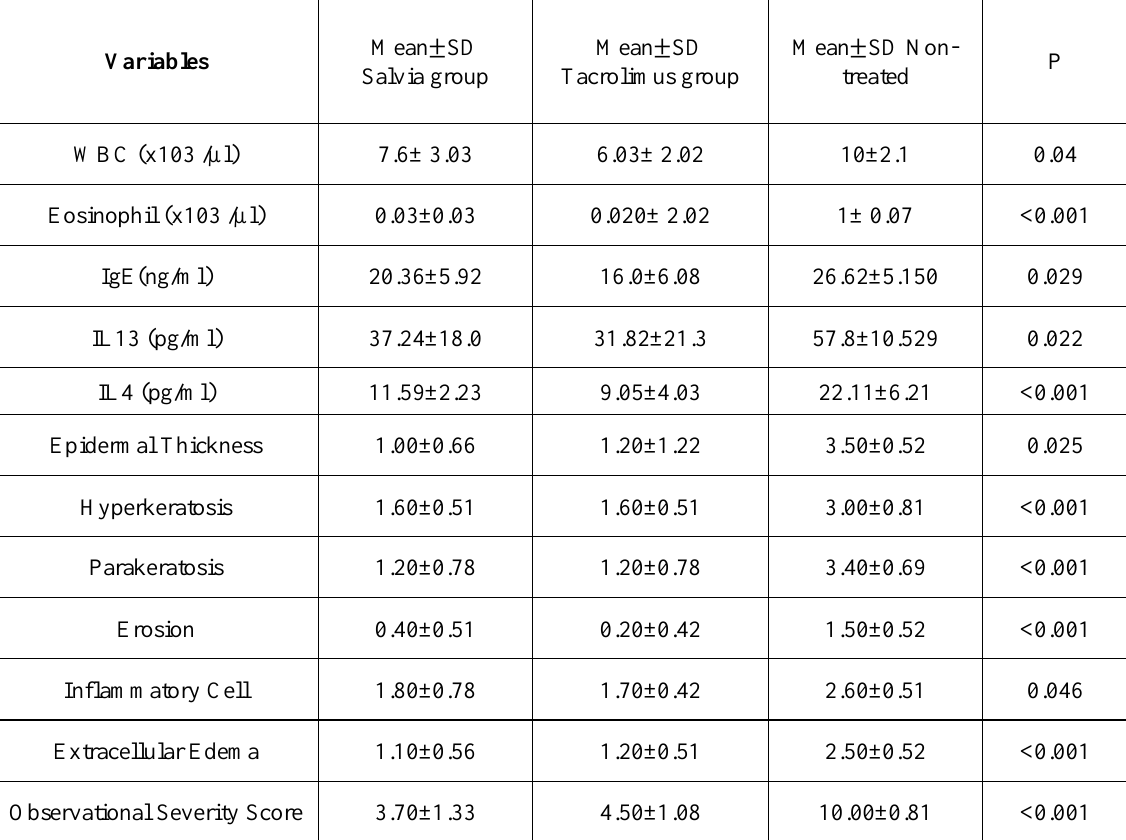
Table 5. Comparison between non treated atopic dermatitis induced group with each of Salvia frigida and Tacrolimus treated groups (by one way ANOVA test) regarding WBC, Eosinophil, serum IgE, and skin tissue homogenate of IL-4 and